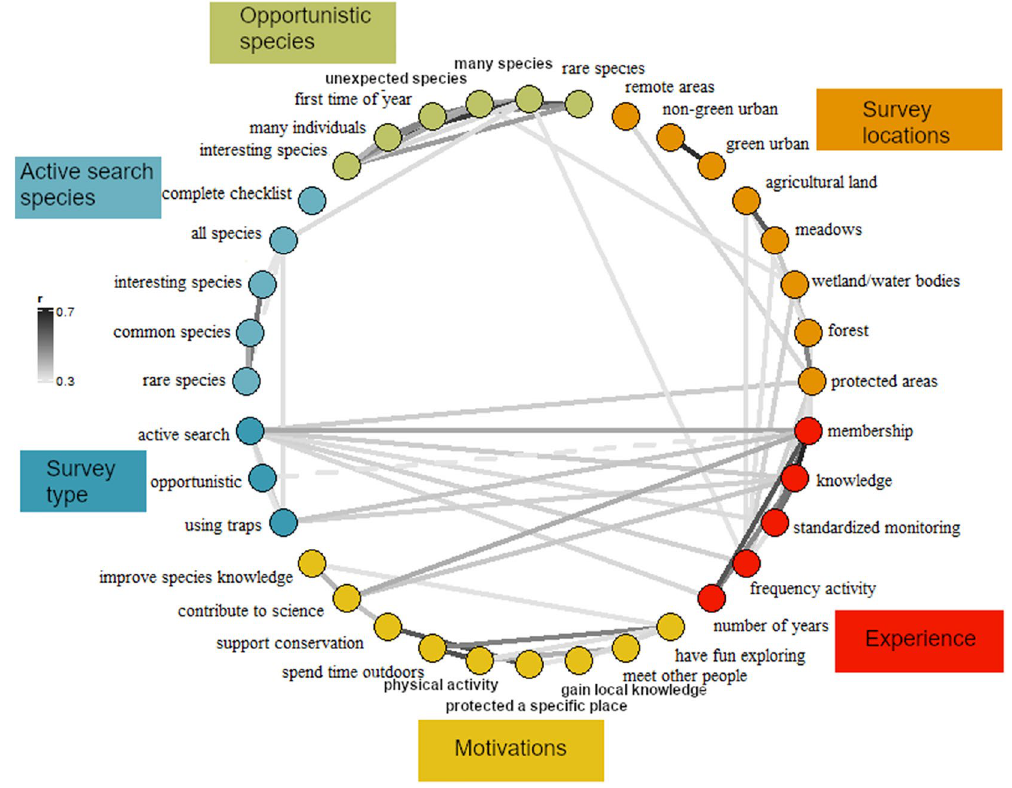
Figure 3. Plot showing the correlations among responses across all questions. Lines connecting two items indicate a correlation with absolute strength of 0.3 or greater between answers of each item, with darker shading indicating stronger correlation strengths. Negative correlations (very few) are shown by a dashed line. Table S1 gives a fuller description of all question